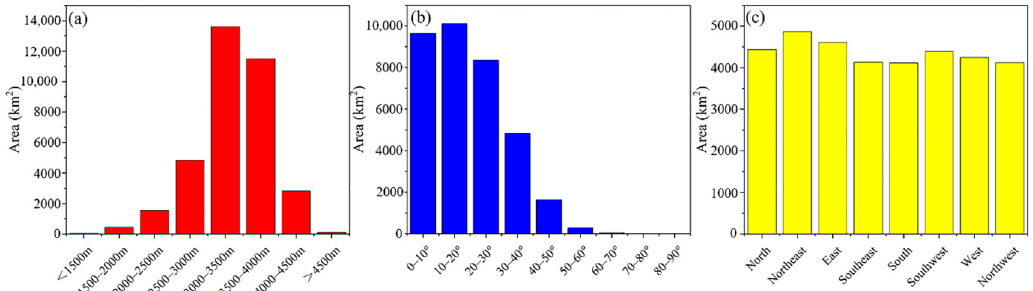
Figure 8. Reclassification of the three selected topographic factors together with their areal statistics across the SGP. Subplots ( a – c ) are for altitude, slope, and aspect, respectively.